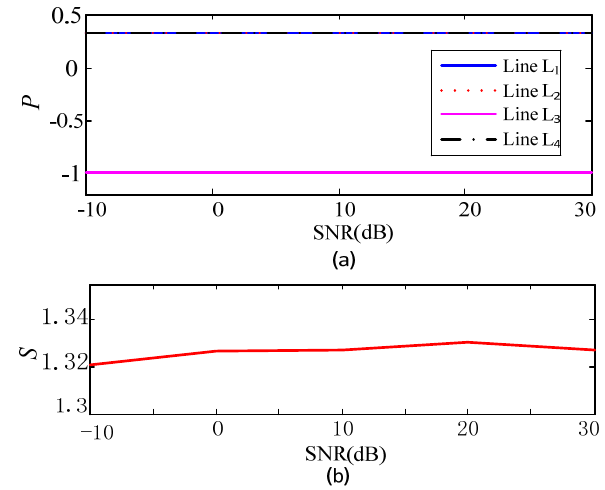
Figure 19. S and P of each feeder for different signal to noise ratios (SNRs). ( a ) P of each feeder for ff erent SNRs; ( b ) S of di ff erent different SNRs; ( b ) S of different SNRs. di